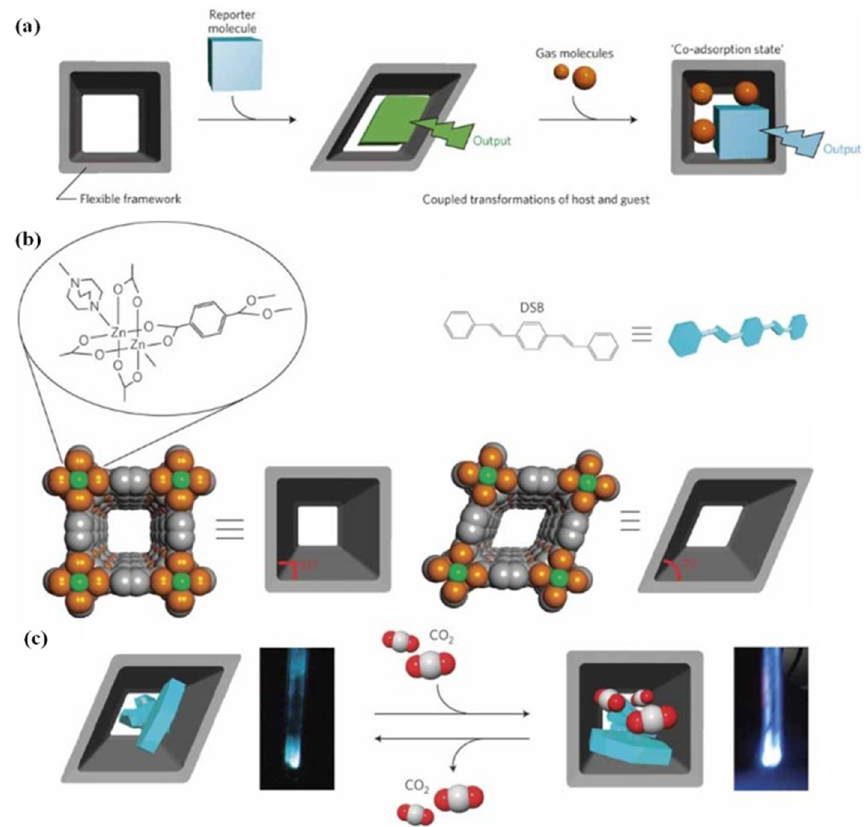
Figure 9. ( a ) Schematic illustration of gas molecule detection mechanism. By inclusion of a re- porter molecule, the flexible coordination polymer framework adapted an induced-fit-type structural change. Upon further gas adsorption, the host–guest structure transformed with pore size variation and conformational variations of the reporter molecule, which leads to a change in output signal. ( b ) Crystallographic illustration of host molecules (left) with metal ion coordination environment zoomed in. The original (left) and deformed (right) structures of host molecules. Chemical structure and representative diagram of reporter molecule DSB. ( c ) CO 2 sensing mechanism. Conformation and fluorescent signal change of host–guest molecules upon the introduction of CO 2 . The pictures of complexes were taken at 195 K under UV irradiation. The removal of CO 2 was accomplished in vacuum at 195 K. Reprinted with permission from Ref. [67]. Copyright 2011, Nature Publishing Group.